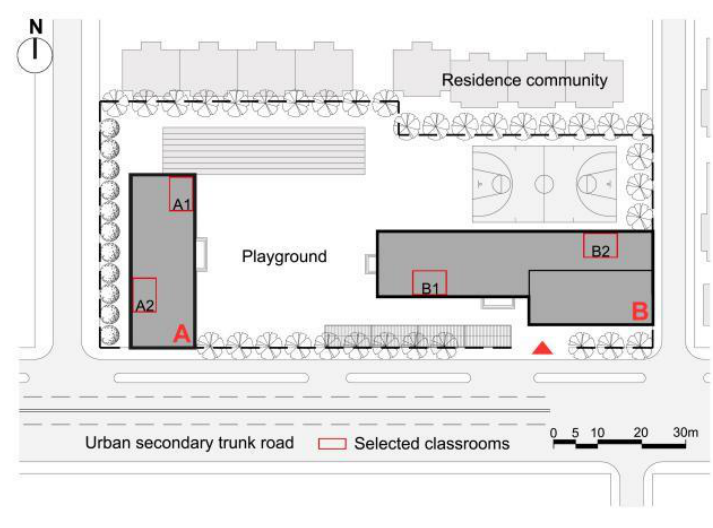
Figure 1. Map of the primary school site.